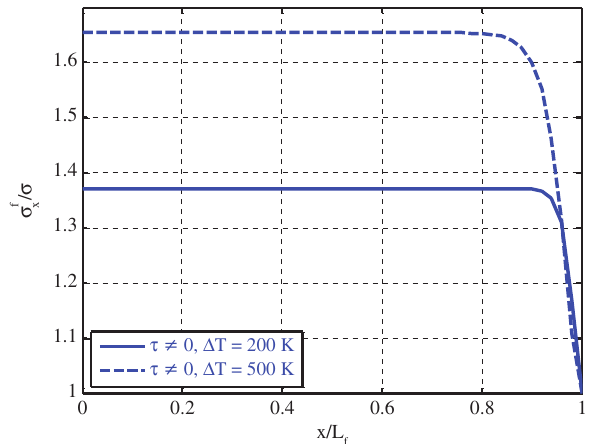
Figure 8: Variation of the axial stress in the carbon fiber along its length.